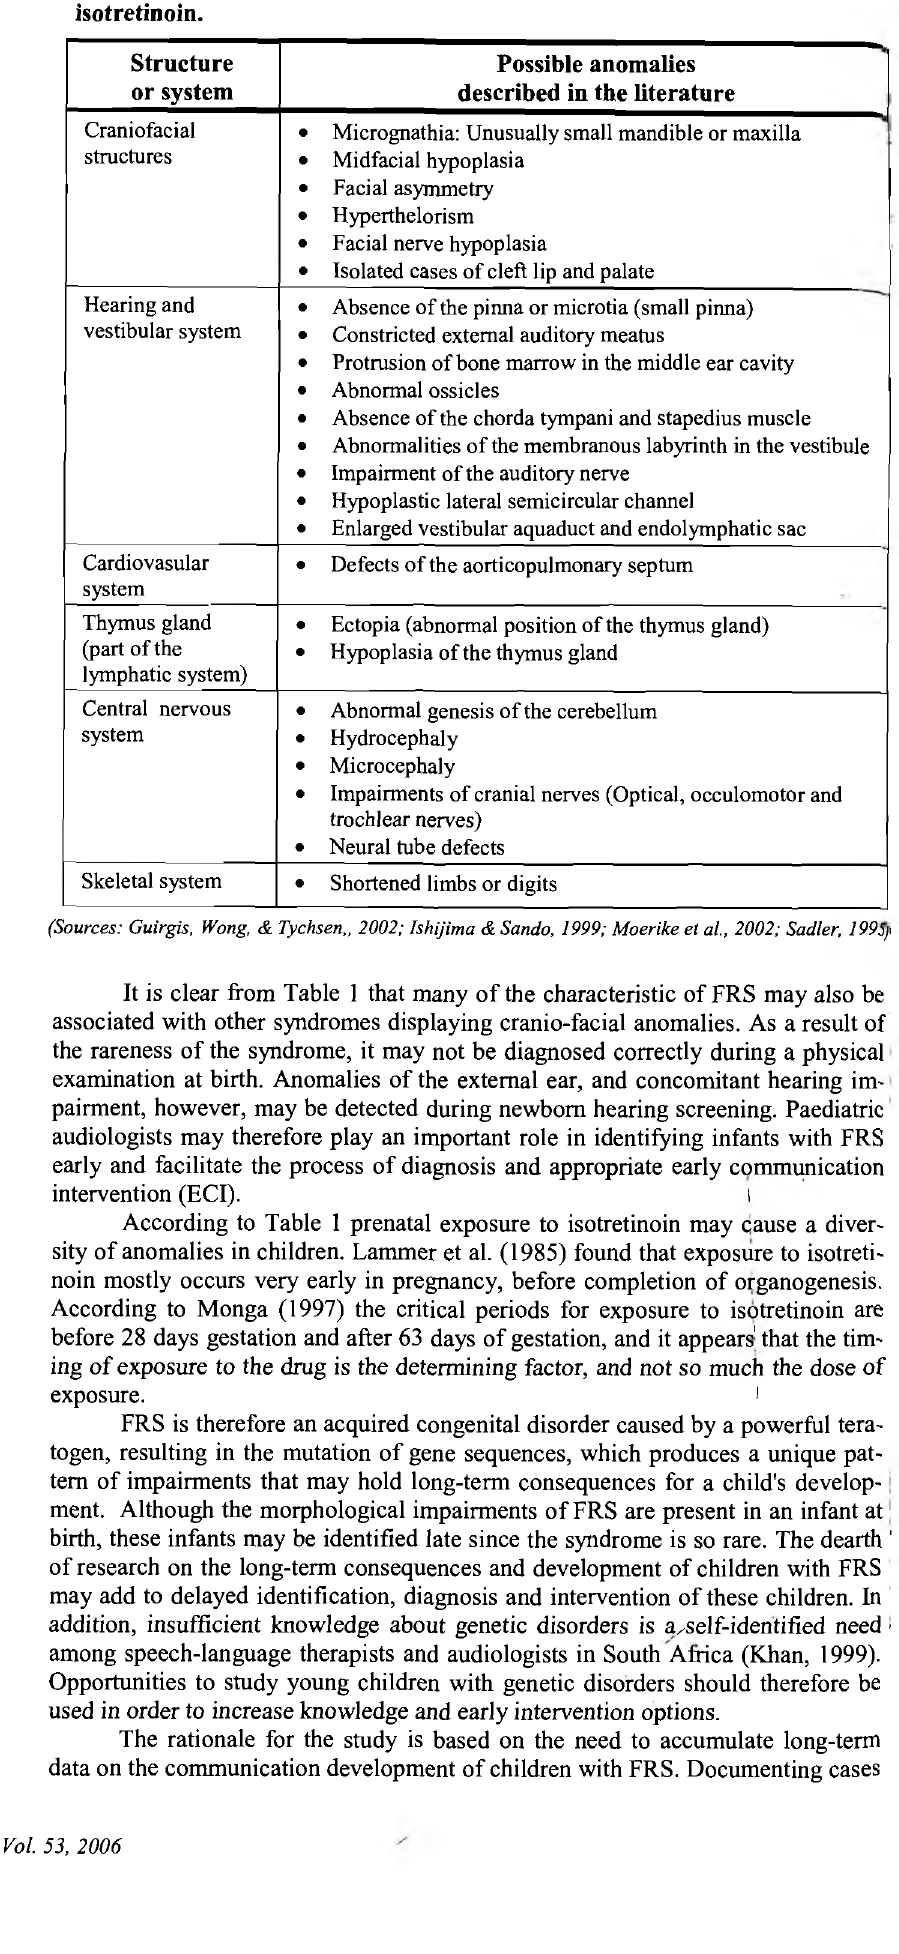
Table 1: Possible congenital anomalies in children prenatally exposed to